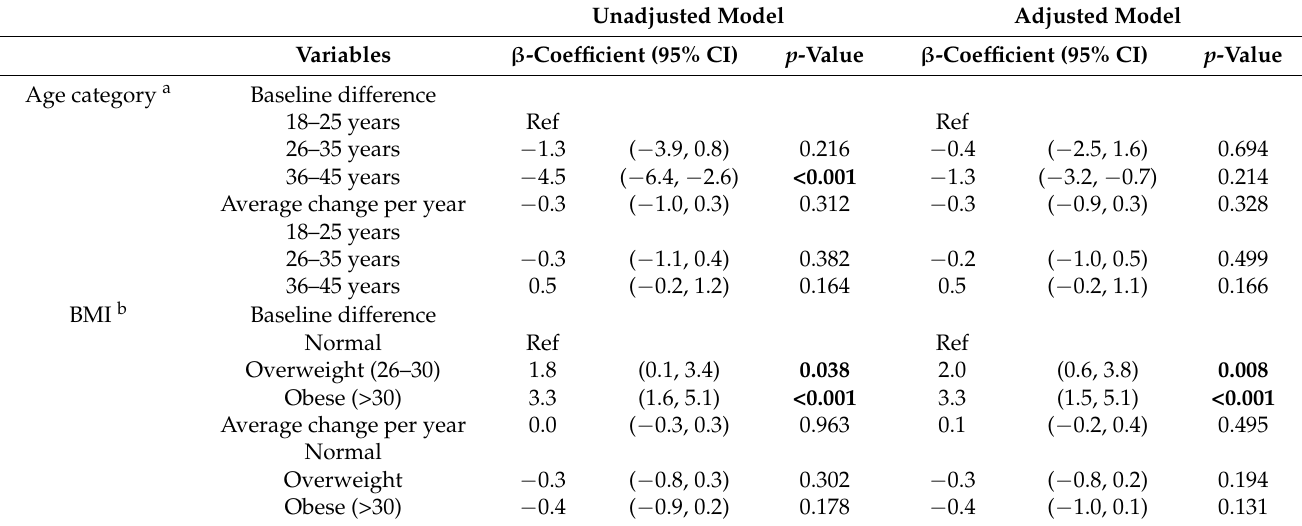
Table 3. Change in sitting time over five years by sociodemographic and health